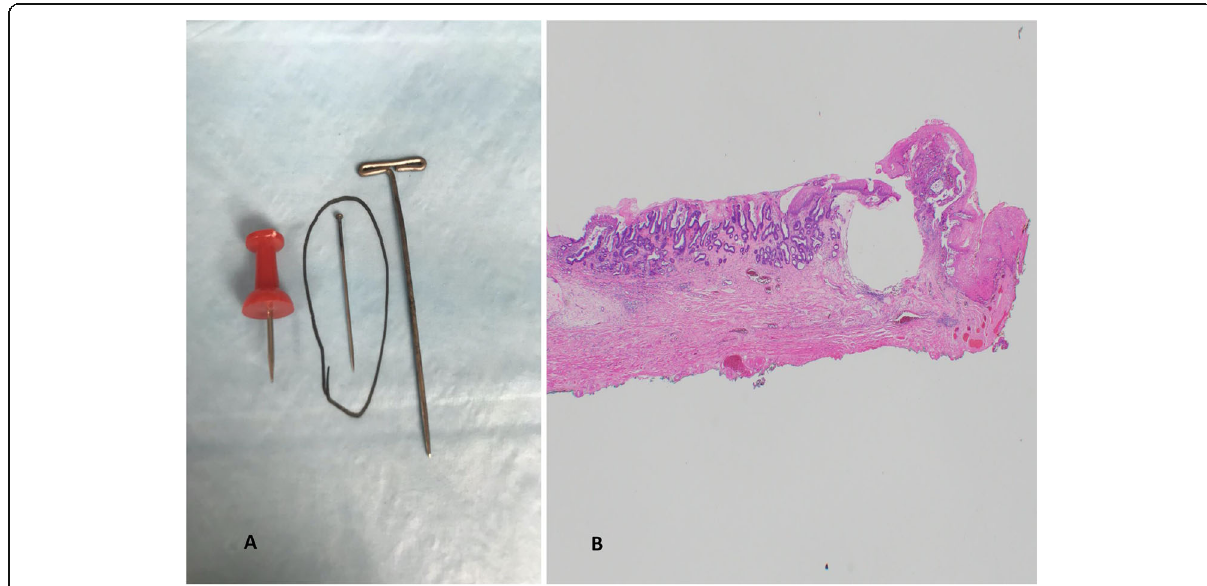
Fig. 7 A . Recommended thin paper pins for pinning the tissue on the board for proper fixation. B . Small pin hole and excellent orientation of the tissue edges for optimal assessment of peripheral margins. Hematoxylin and Eosin stain ×